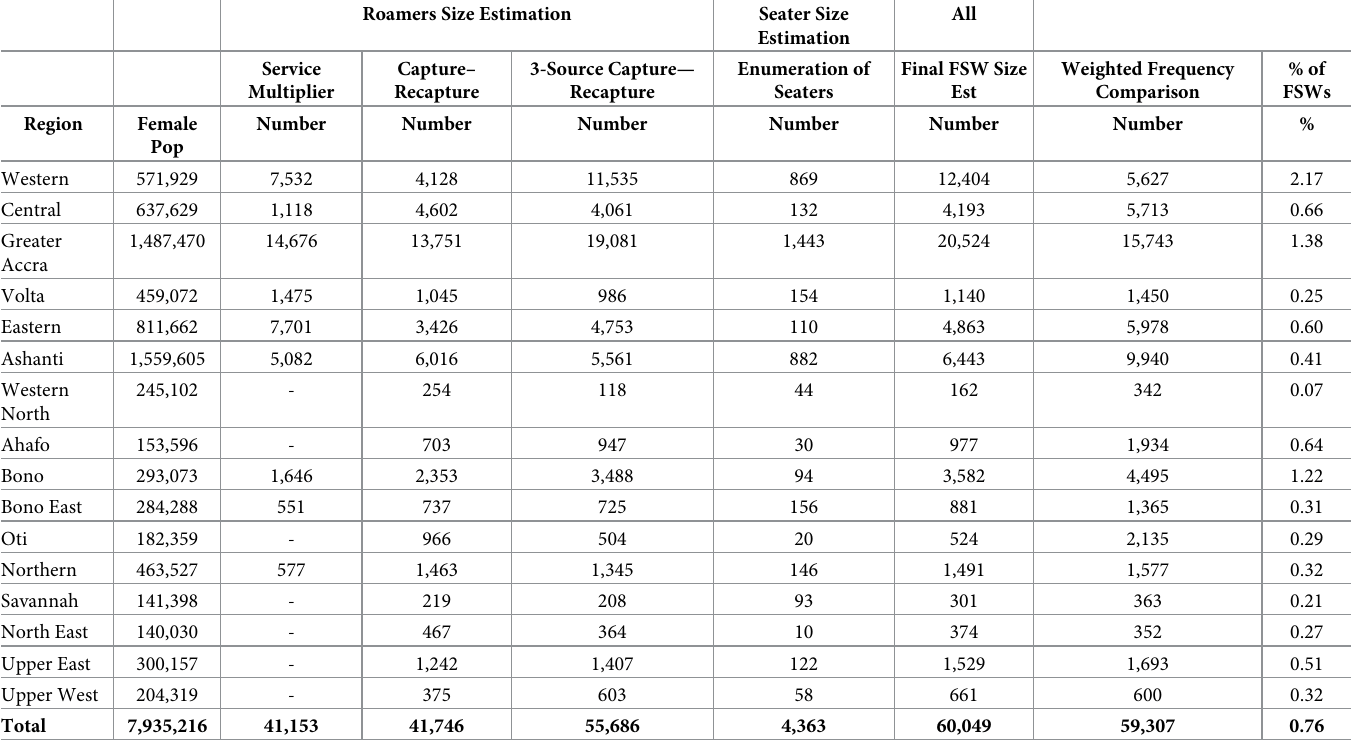
Table 4. Summary total estimates of seater (census) and roamer (service multiplier, CRC, and 3SCRC) FSW by region according to